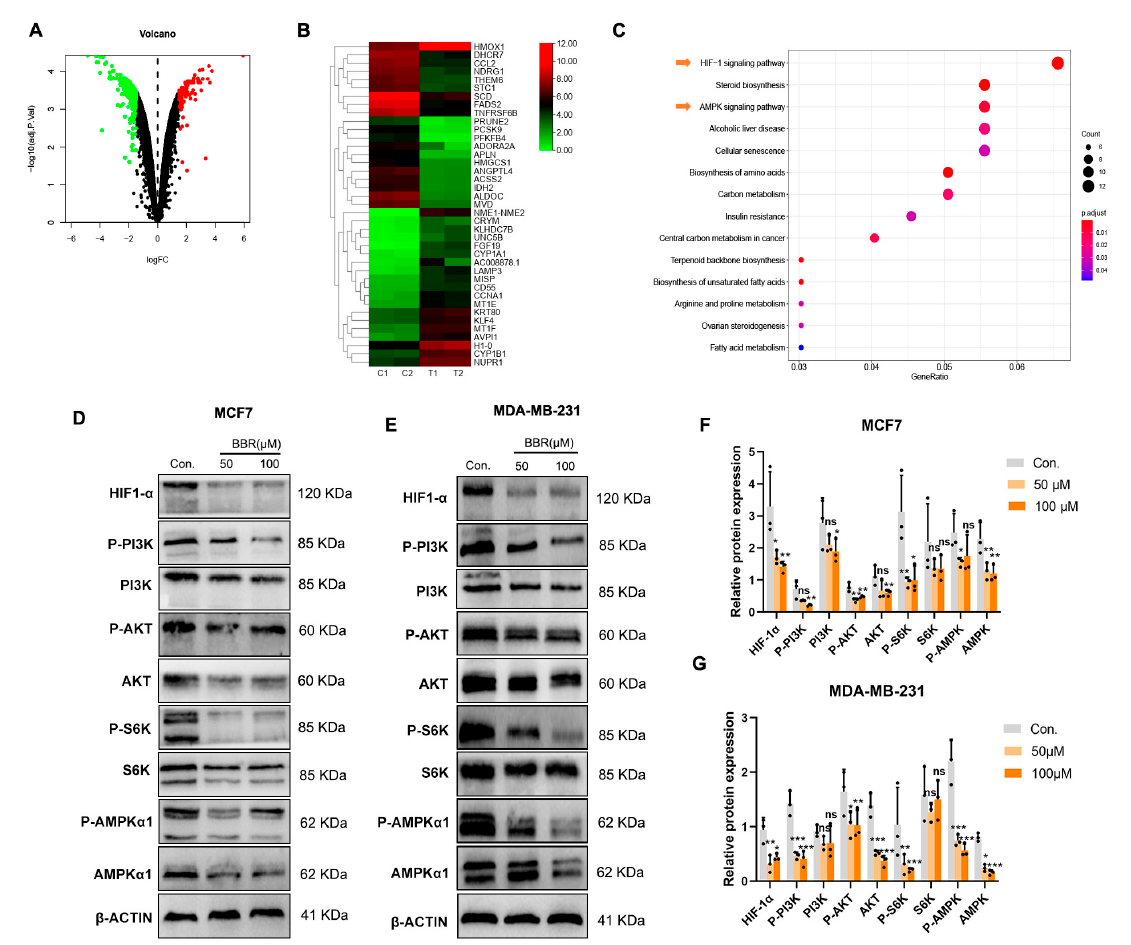
Figure 3. Signaling pathway enrichment of BBR based on RNA-seq. The volcano map shows DEGs ( A ).. The heat map shows the top 20 upregulated and downregulated genes (C1, and C2: control group; T1 and T2: BBR treatment group; red, upregulated genes; green, downregulated genes) ( B ). KEGG demonstrates pathways for DEG enrichment in transcriptome sequencing ( C ). Western blot was used to demonstrate the changes in related pathways’ genes at the translation level in MCF7 and MDA-MB-231 ( D – G ) cells. ns: not statistically significant, * p < 0.05, ** p < 0.01, *** p < 0.001. Data represent the means ± SD of three independent experiments.